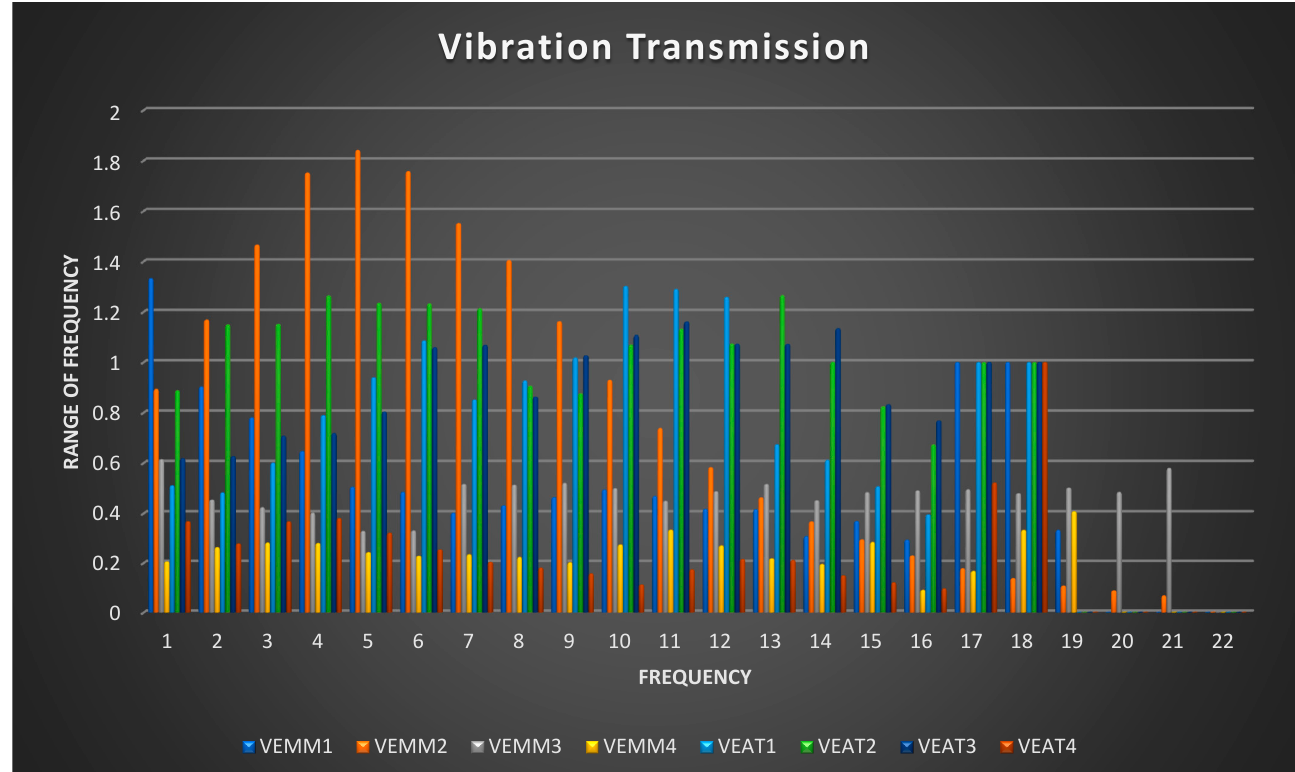
The 1/3rd–octave band average vibration transmissions shown in Table 9 on various 22 frequencies are shown graphically in Figure 4.